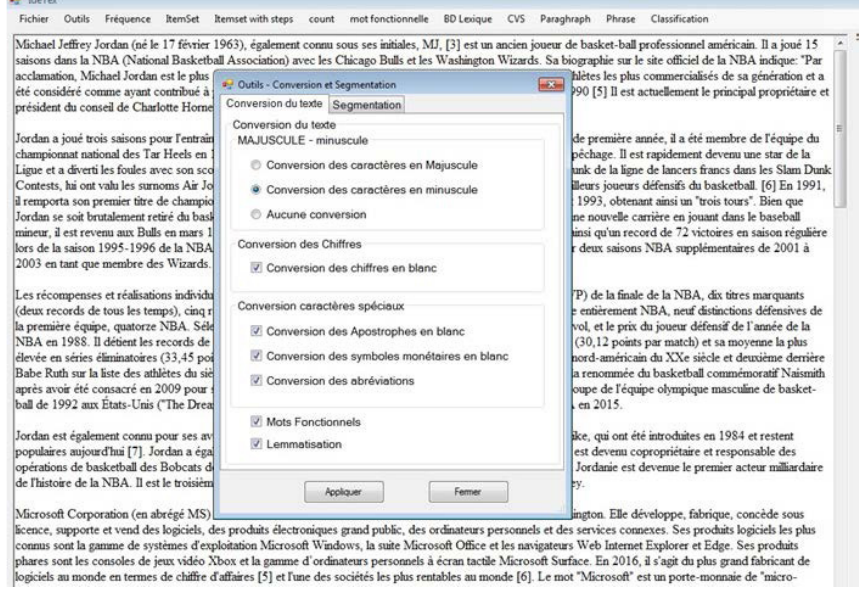
Fig. 4. Text cleanup